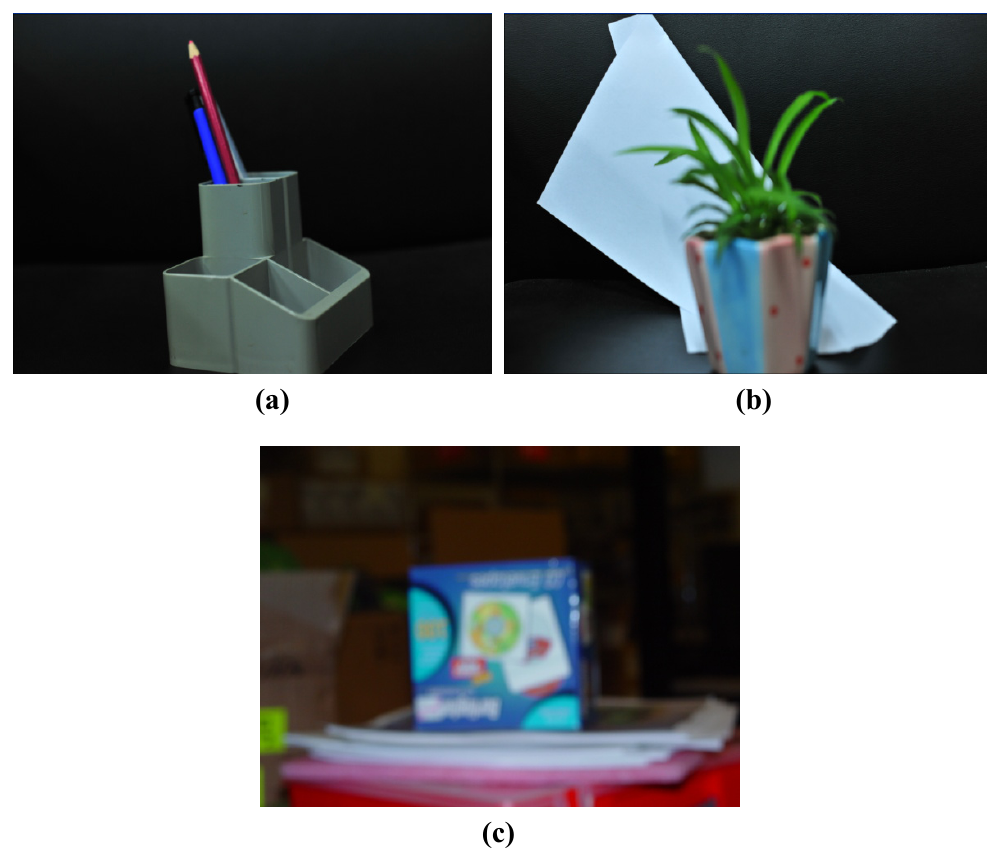
Figure 5. Image used in the experiments (a) Object A. (b) Object B. (c) Object